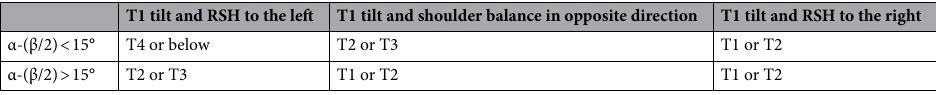
T1 tilt and RSH to the left T1 tilt and shoulder balance in opposite direction T1 tilt and RSH to the right α-(β/2) <